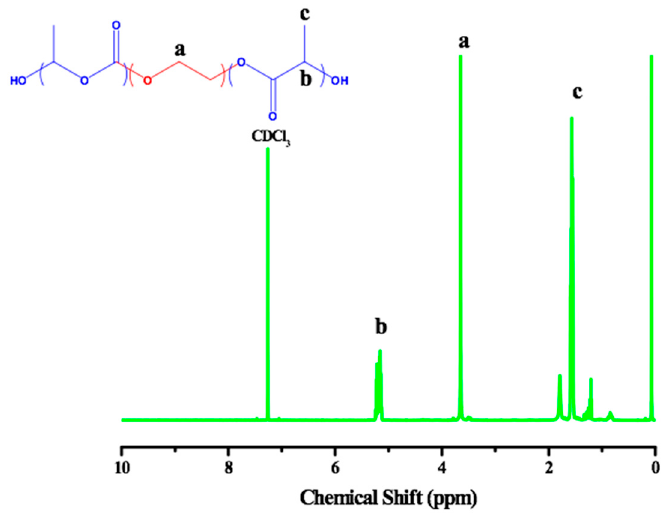
Figure 1. 1 H NMR spectrum of LEL triblock copolymer.